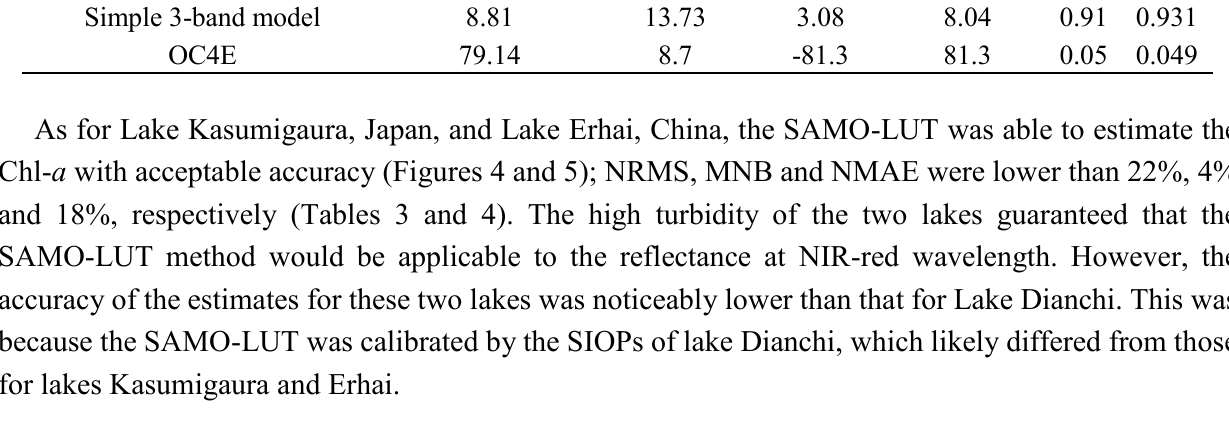
Figure 4. Comparison of the measured and estimated Chl- a by the SAMO-LUT for Lake Kasumigaura,